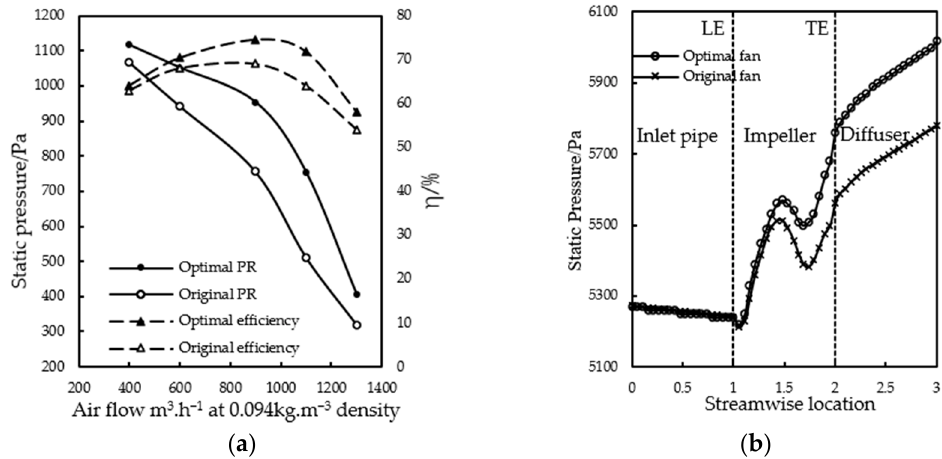
Figure 5. ( a ) Comparison of static pressure rise and fan efficiency before and after optimization; ( b ) Fan static pressure distribution along the streamwise. ( b ) Fan static pressure distribution along the